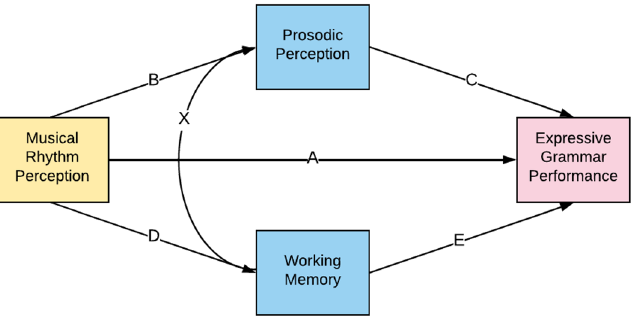
Figure 2. Path model for mediation analysis of musical rhythm perception and expressive grammar performance. This path model examines the relationship between musical rhythm perception (predictor) and grammar performance (outcome), and the possible mediators (working memory capacity and prosody perception) that might play a role in this correlation. Path A is the direct effect from rhythm to grammar, while paths BC and DE constitute the mediation effects through prosodic perception and working memory respectively. Path X depicts the residual correlation between prosodic perception and working memory.